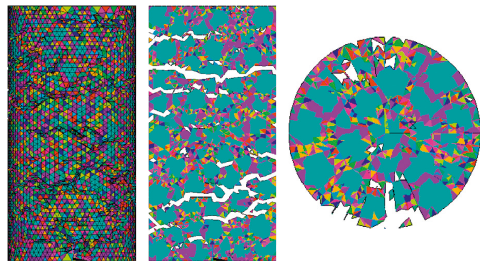
Figure 7: The damage element figure of